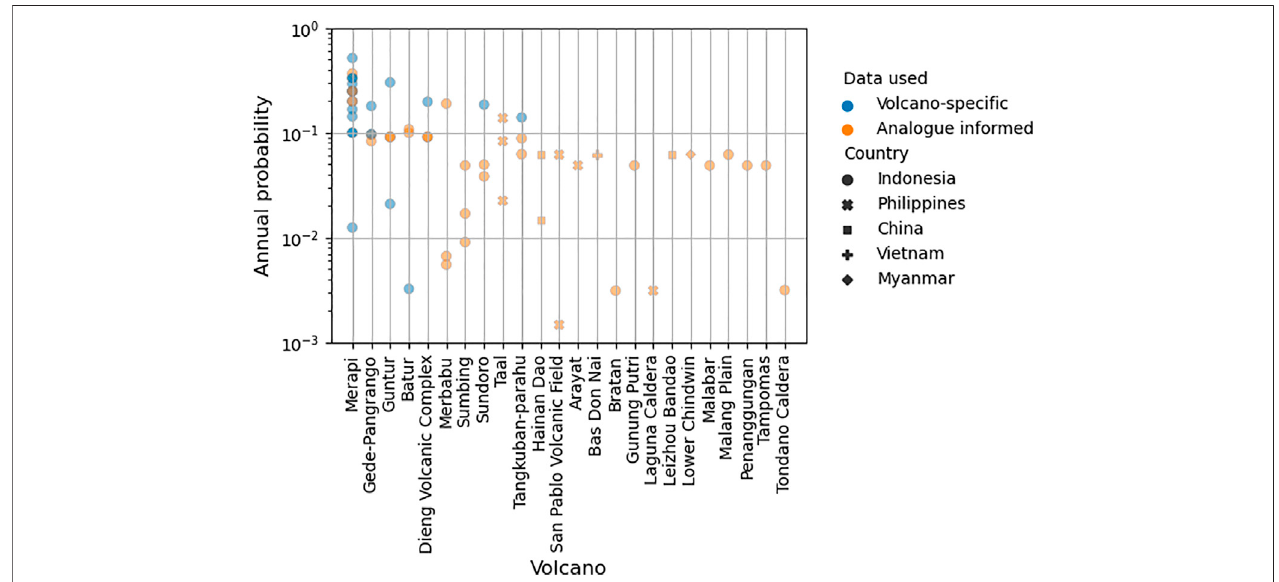
FIGURE 4 | Published annual probability of eruption for subset of volcanoes in Southeast Asia (ordered by number of published estimates). Volcano-speci fi c includesthosestudiesthatusesdataonly fromthevolcanoofinterest,whilst analogue-informedmeansthatthestudyincorporatedsomeformofanalogue approachto attainthefrequency/probabilityestimate.Datafrom:Andreastutietal.(2000);Sagala(2009);Gertisseretal.(2012);Suronoetal.(2012);Jenkinsetal.(2012);Bebbington (2014); Purwadi et al. (2016) citing Newhall et al. (2000); Jenkins et al. (2015); Bear-Crozier et al. (2016); Miller et al. (2016); Napsiah et al. (2017). See Supplementary Material for detailed values.